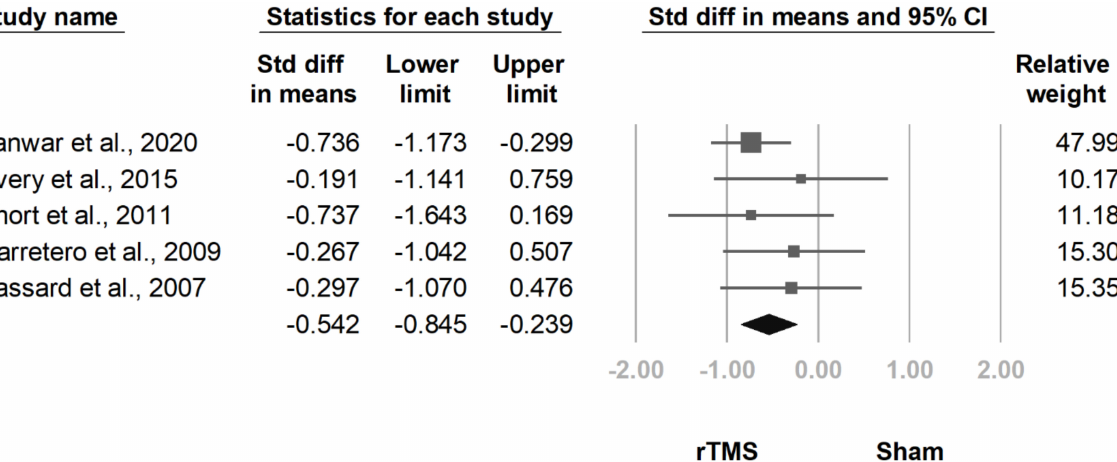
Figure 18. Forest plot of standardized mean differences in Hamilton Depression Rating Scale at follow-up at two weeks to one month after last treatment session. Squares indicate effect sizes of individual studies, lines indicate 95% CI, and diamond indicates the summarized effect size.